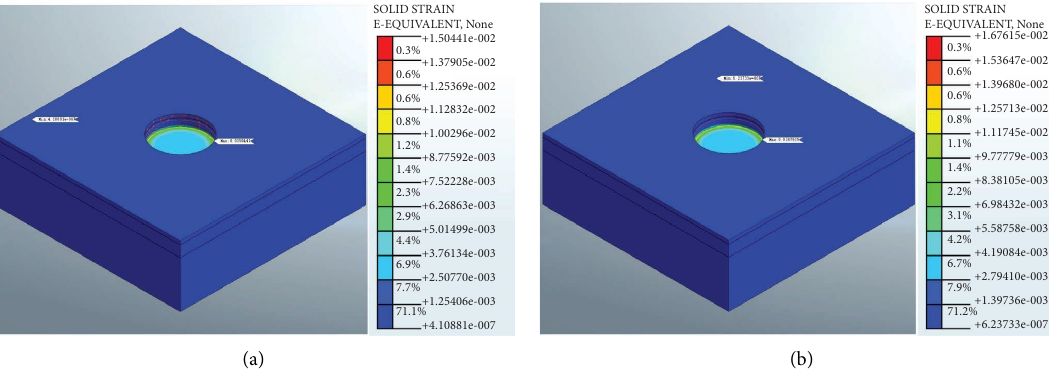
Figure 15: Working condition 6. Equivalent soil strain (a) without pore water pressure and (b) with pore water pressure applied.